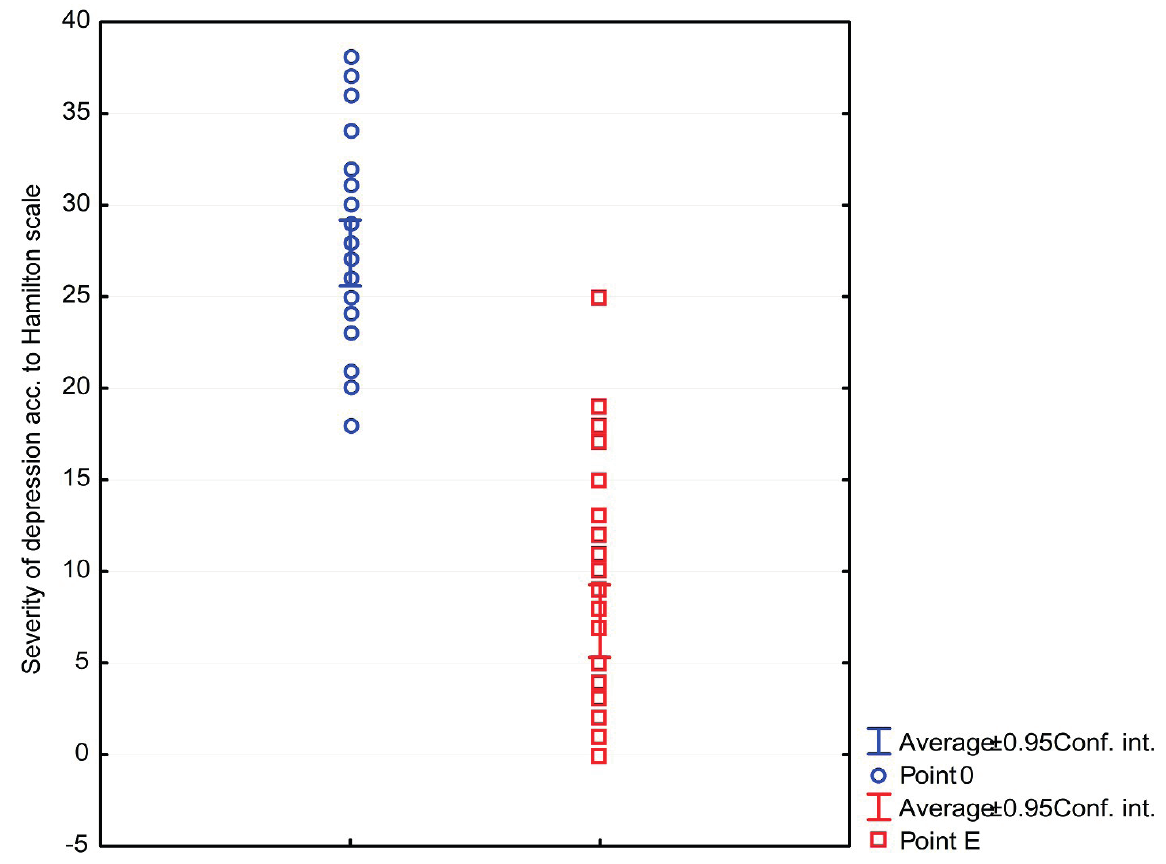
Fig. 5 Scatter plot with 95% confidence interval showing the severity of depression according to the Hamilton scale at two points in time.